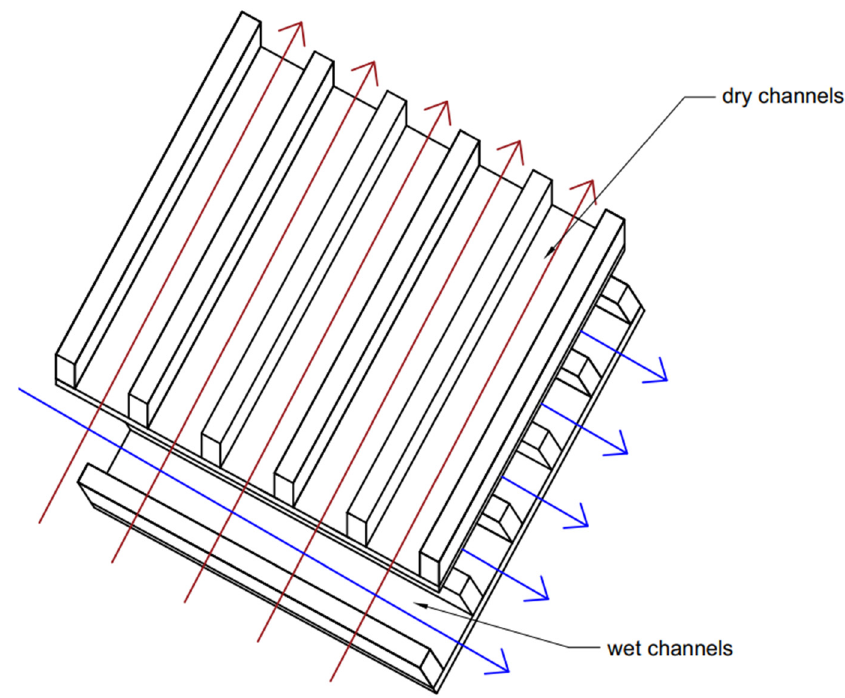
Figure 4. Diagram of a heat and mass exchanger [22].